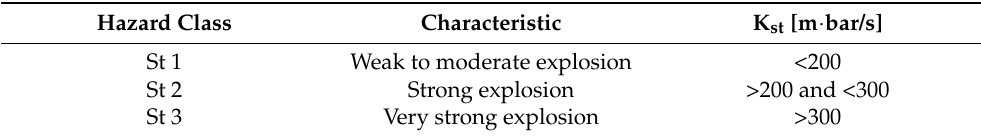
Table 3. Division of explosive dusts into particular